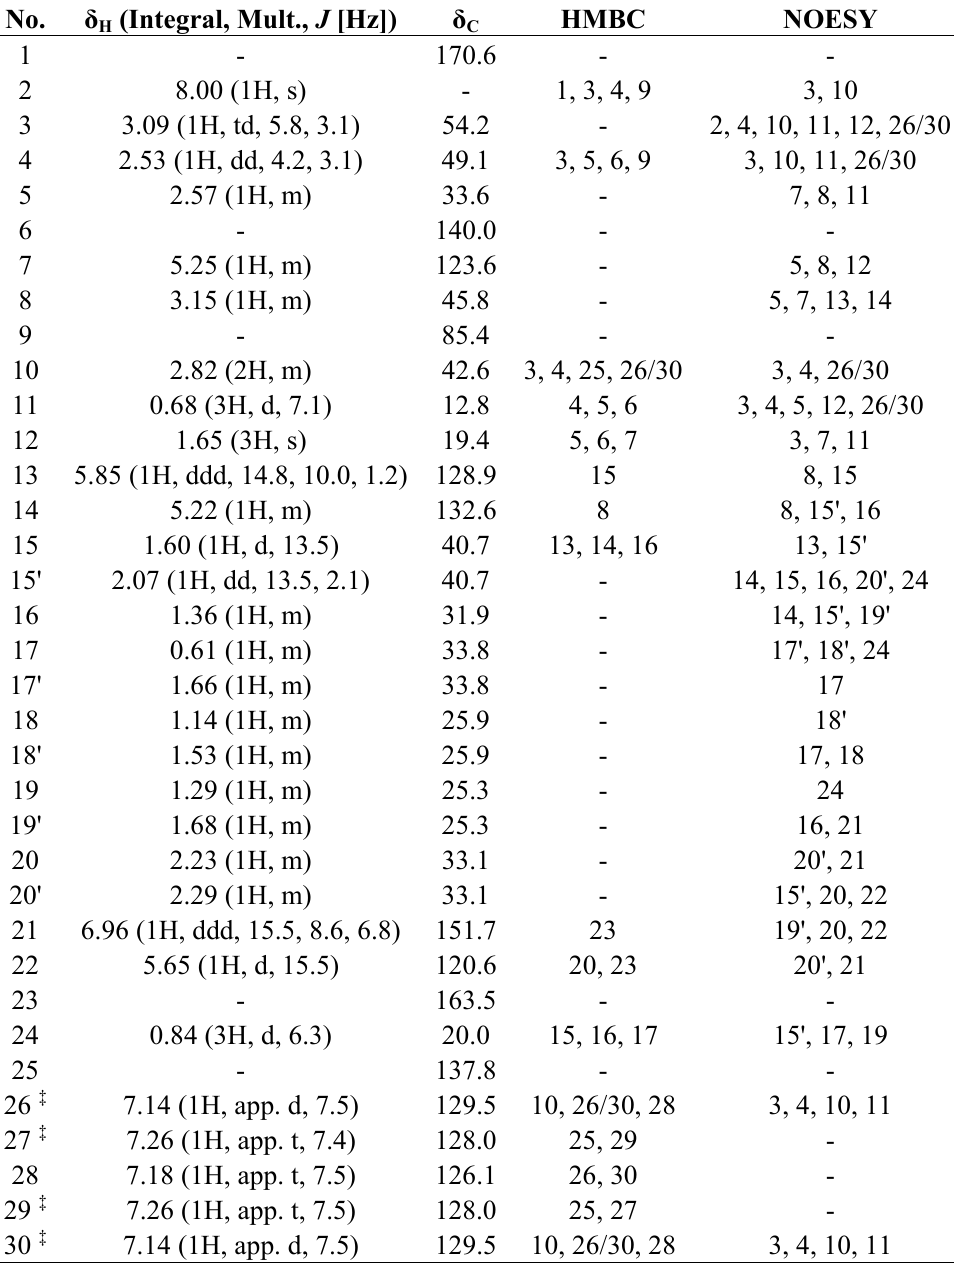
Table 1. NMR data for sclerotionigrin A ( 1 ) †